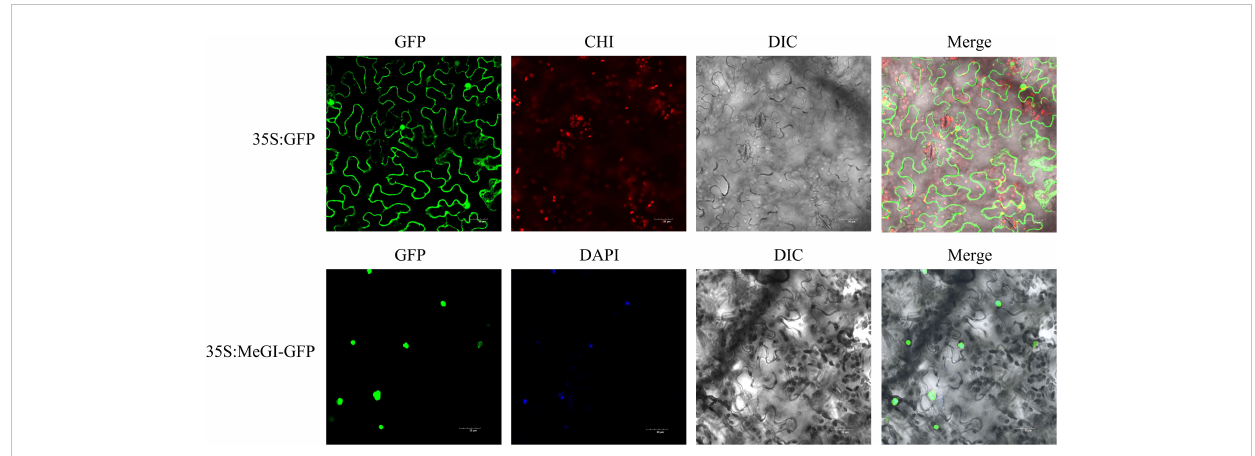
FIGURE 2 Subcellular localisation of the MeGI protein in tobacco mesophyll cells. The fusion protein (MeGI-GFP) was transiently expressed in tobacco. DAPI was used as the nuclear localisation marker. GFP, Green fl uorescence fi eld; DAPI, DAPI fi eld (nuclear staining); CHI, Chloroplast auto fl uorescence fi eld; DIC, Bright fi eld; Merge, superposition fi eld. Bars, 30 m